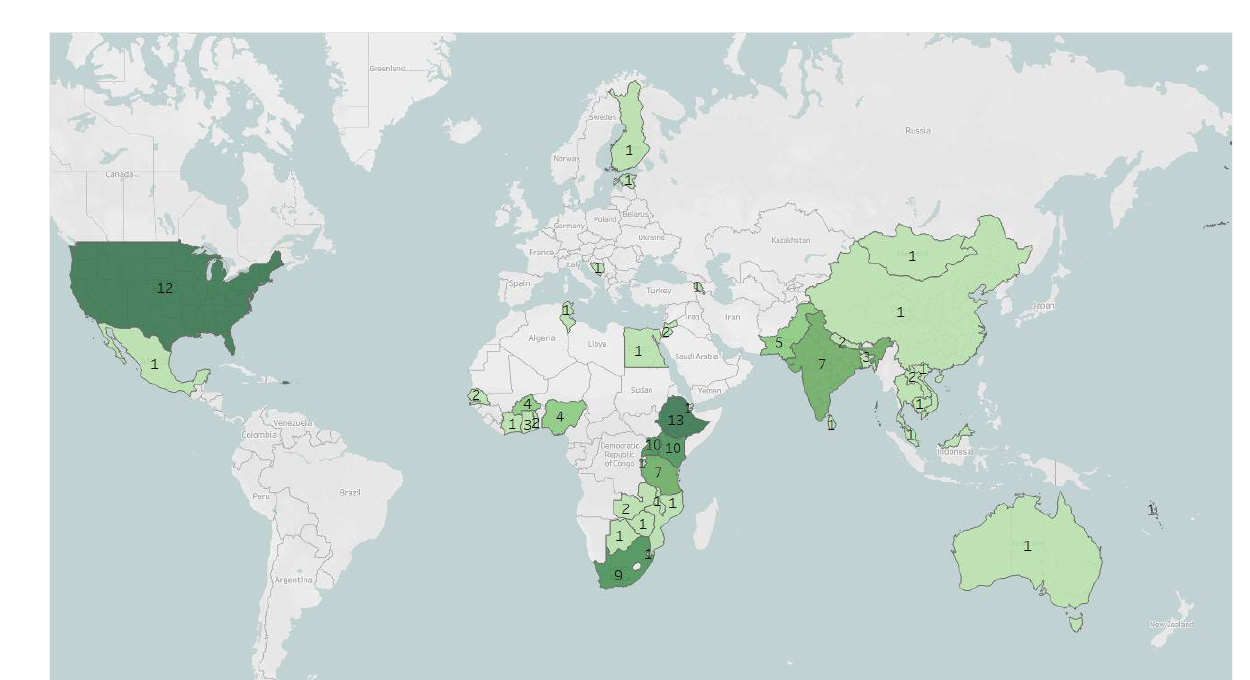
Figure 2. Study countries, including number of studies conducted within each country. (Note: Color shading corresponds to the number of studies conducted within a given country, with darker shading corresponding to a greater number of studies. Some studies were conducted in multiple countries). Table 3. Research studies and evaluations included in review .